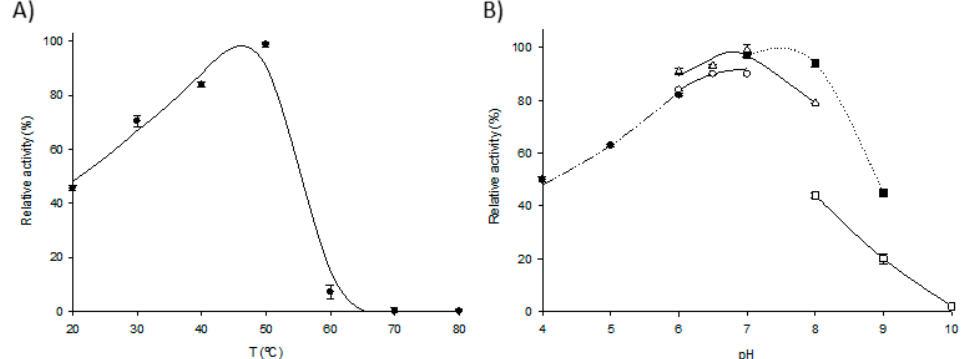
Figure 3. Biochemical characterization of the M Lm PDT3/M Ec HPRT3 system. ( A ) Effect of tempera ‐